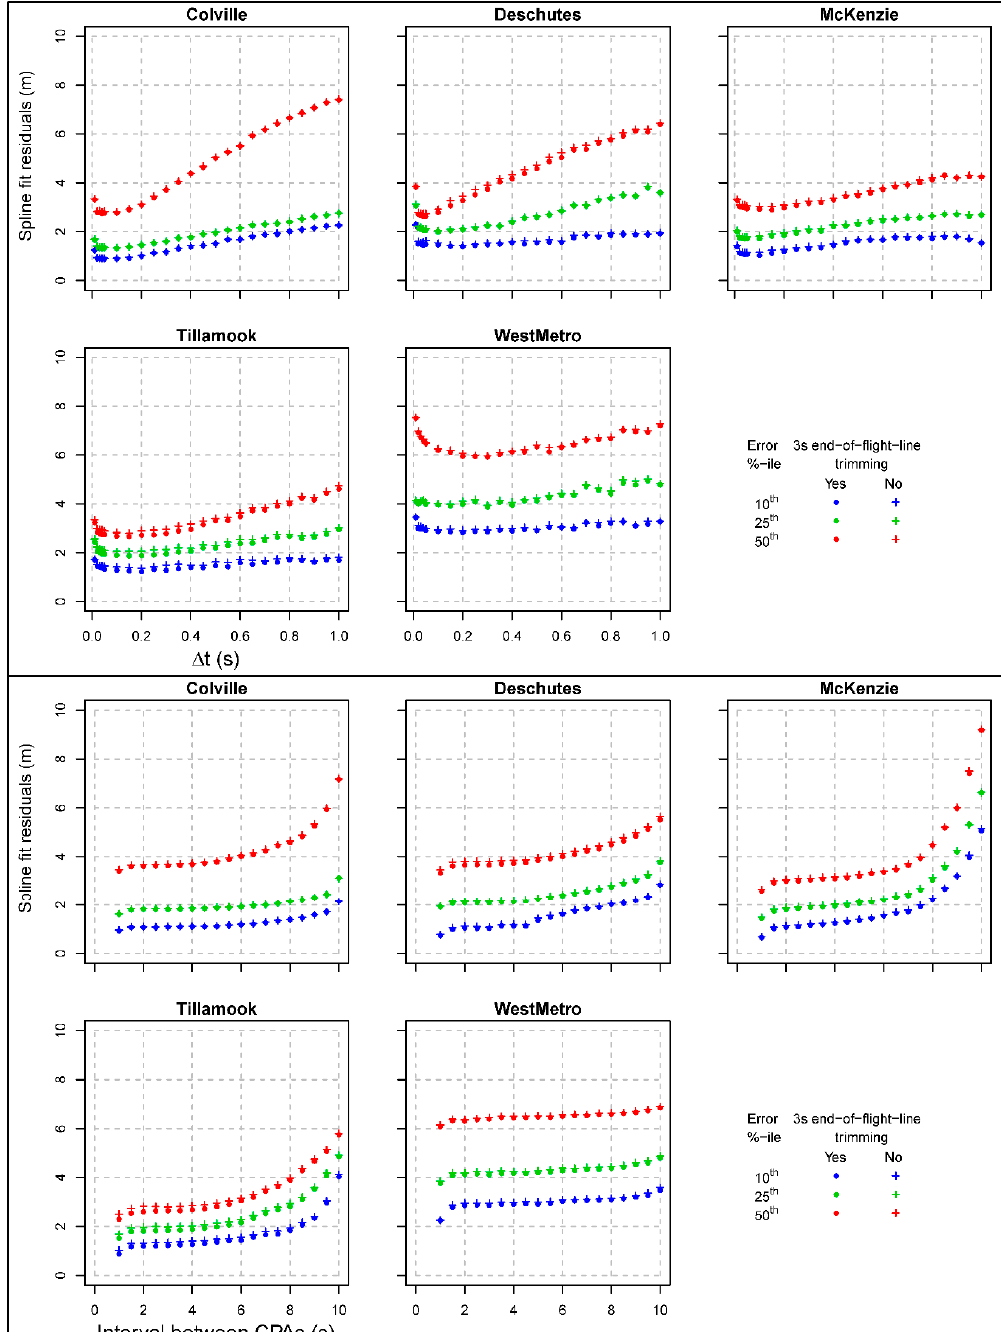
Figure 6. Distribution of residuals in splines fit to flight-line-specific CPA sets across study areas as function of time block duration ( top ) and time intervals between CPAs used in the fitting ( bottom ). Crosses indicate the entire CPA set was used for each flight line; dots denote CPAs trimmed by 3 s on either end.